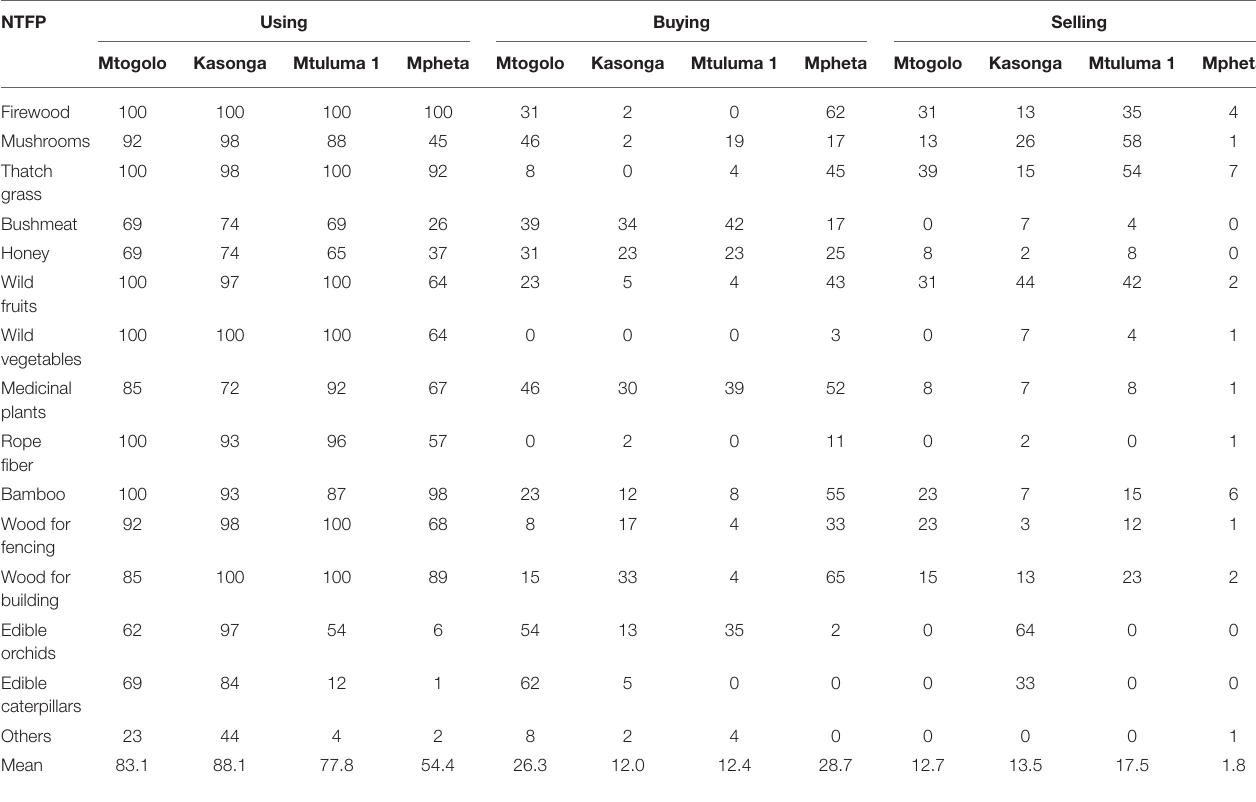
TABLE 2 | Proportion (%) of households ( n = 268) using, buying, or selling different NTFPs in four villages.